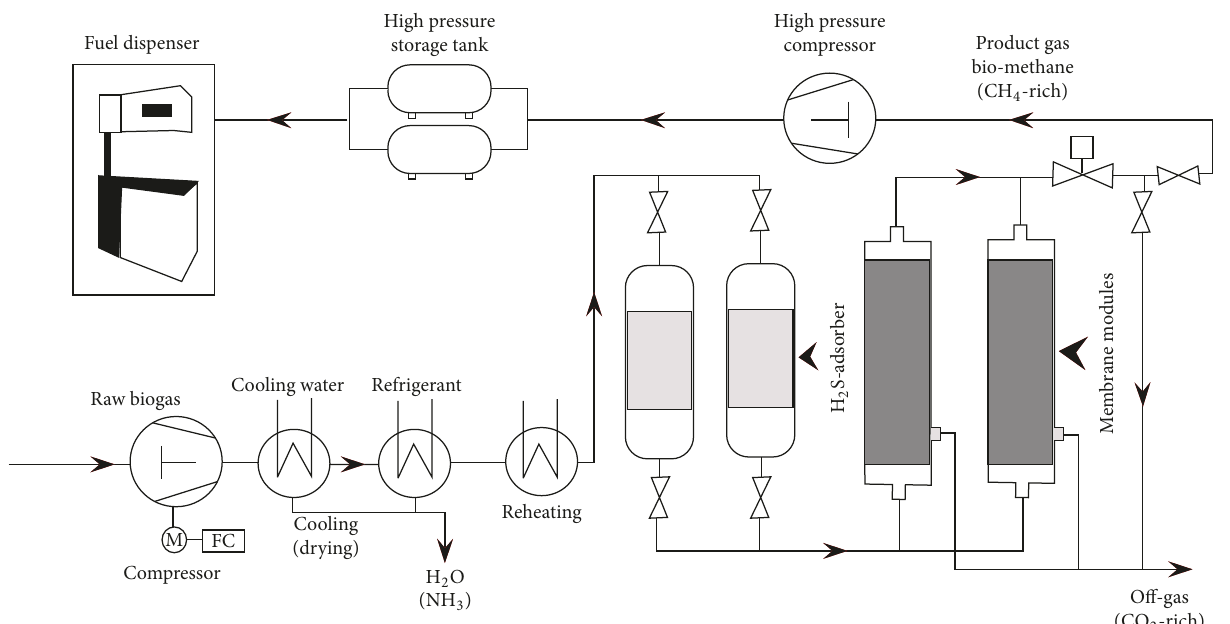
Figure 4: Schematic diagram of total bio-CNG process and vehicle fueling method [55].